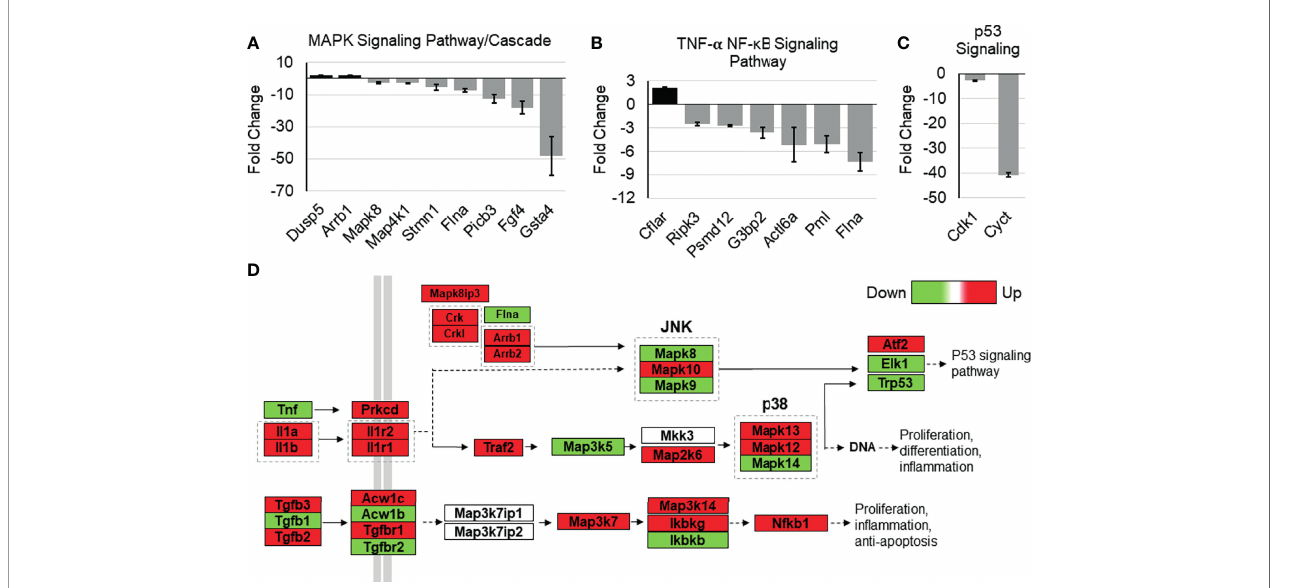
FIGURE 7 | Effects of Tip110 knockout on gene expression in several NF- k B-related signaling pathways. Affymetrix Transcriptome Analysis Console software provided a list of pathways found in WIKI Pathways Beta that were most perturbed by Tip110 loss. This information was used to construct bar graphs depicting the fold change of some of the associated genes. Genes associated with MAPK (A) , TNF- a -NF- k B (B) , p53 (C) , signaling pathways were included. (D) Data from Affymetrix microarray analysis of wild-type and Tip110 knockout-mouse embryonic stem cell RNA revealed the fold changes of genes in these networks. Genes are shown in red when upregulated and in green when downregulated. Pathway information was adapted from MAPK and other signaling pathways depicted in WIKI Pathways